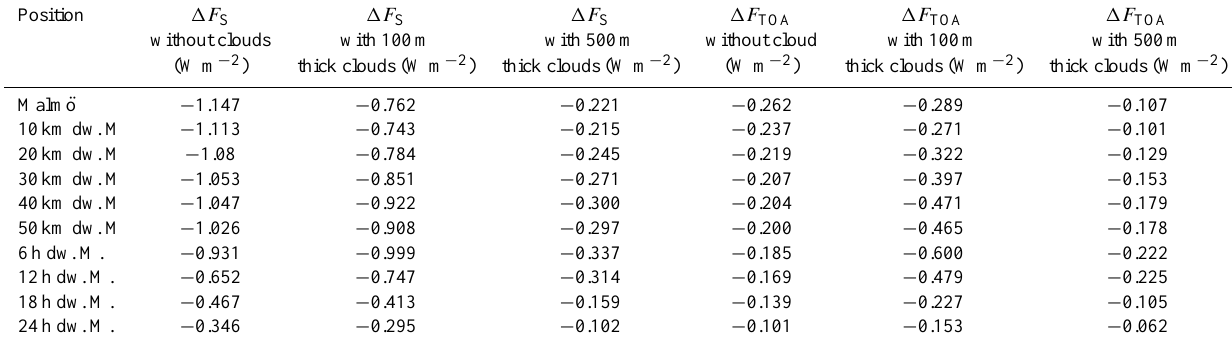
Table 4. Average radiative forcing within the 20km wide model domain at the surface ( 1F S ) and at the TOA ( 1F TOA ) , with or without clouds, at different distances downwind of